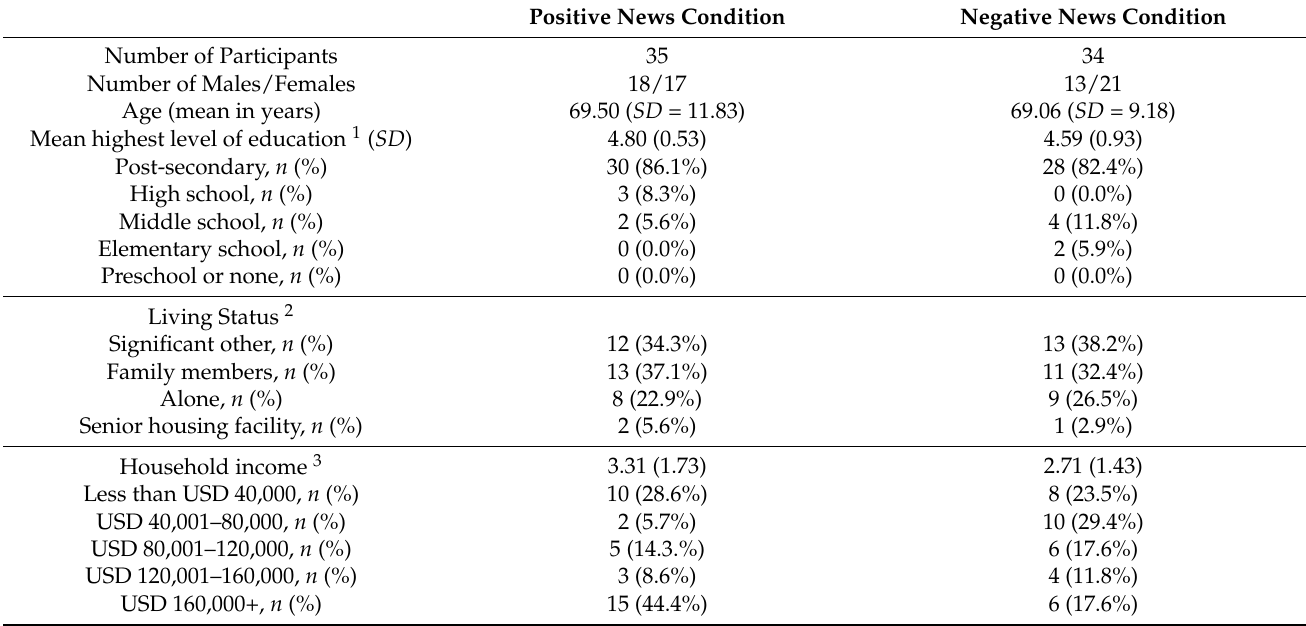
Table 1. Demographics of Participants by